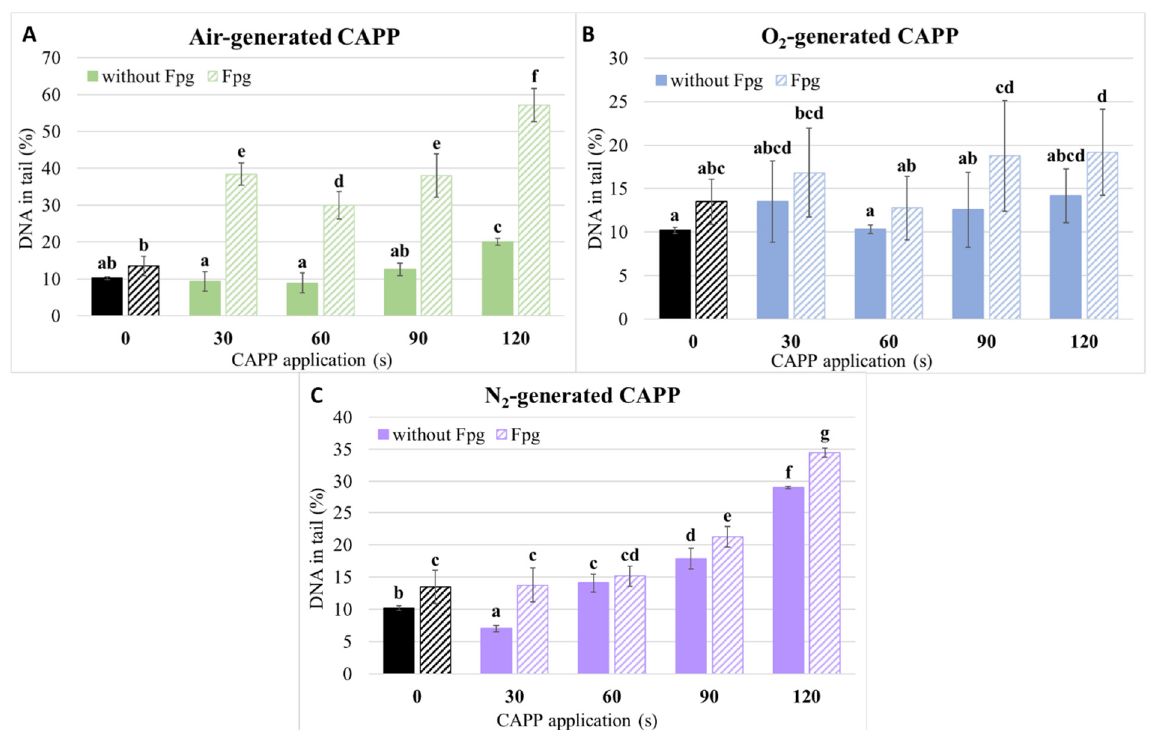
Figure 7. Level of DNA damage in 3-day-old maize seedlings detected by the neutral comet assay and its modification with enzyme formamidopyrimidine glycosylase (Fpg) after the treatment of maize grains with Cold Atmospheric Pressure Plasma (CAPP) generated in ambient air ( A ), oxygen ( B ) or nitrogen ( C ). 0 s—negative control (NC; no treatment); 30, 60, 90 and 120 s—treatment of grains with CAPP for 30–120 s; at least 100 nuclei were analyzed per slide. The data were analyzed using the statistical method LSD ANOVA and comparisons between the mean values were considered significant at p 0.05. Different letters indicate significant difference at p -value < 0.05, bars are the means of three experimental runs ± SD.